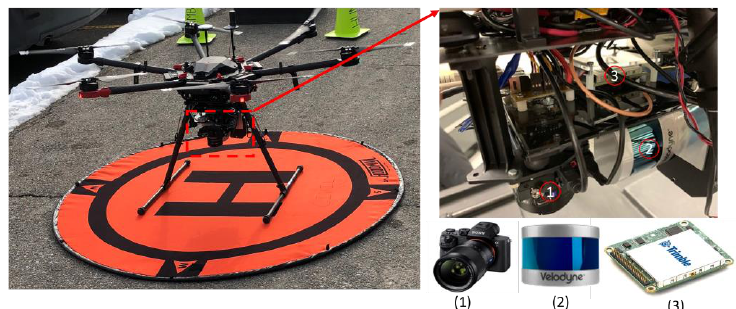
Figure 1. UAS used in the study and its payload: (1) Sony α7R II camera (2) Velodyne PUCK LiDAR sensor (3) Applanix APX-15 GNSS/IMU board.